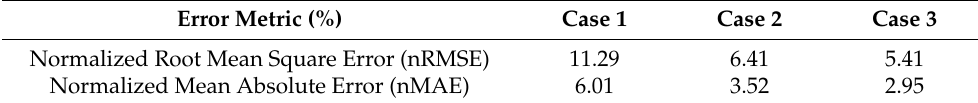
Table 7. Regional PV generation forecasting error without detection and capacity estimation.